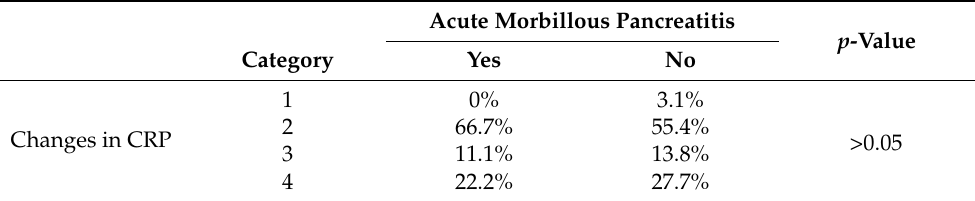
Table 3. Associations between CRP changes and the presence of acute morbillous